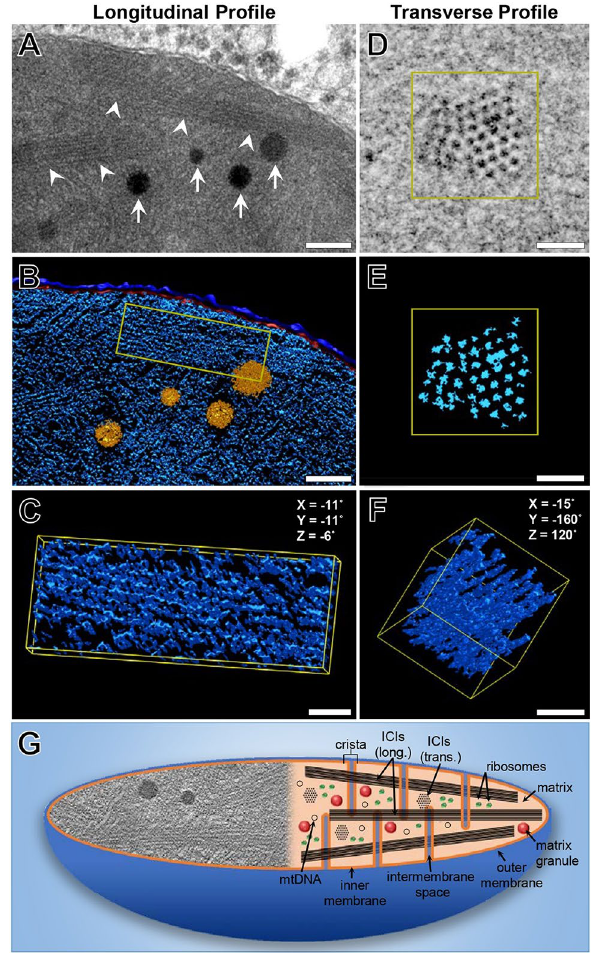
Figure 5. The 3-D structure of intramitochondrial crystalline inclusions (ICIs) and enlarged matrix granules revealed by transmission electron tomography. ( A ) High-magnification image (15,000× magnification) of longitudinal arrays of ICIs (arrowheads) and enlarged matrix granules (arrows) distributed throughout the mitochondrial matrix. ( B ) 3-D model view of the outer- (dark blue) and inner mitochondrial membranes (red), ICIs (light blue) and enlarged matrix granules (orange), corresponding to ( A ). ( C ) Higher-magnification model view of a bundle of ICIs corresponding to the yellow bounding box in ( B ). ( D ) High-magnification image (30,000× magnification) and corresponding model view ( E ) of a bundle of ICIs in transverse section. The individual rod-like filaments appear to be composed of globular subunits, measuring 8.65 ± 1.31 nm in diameter and are arranged in a rhomboid pattern with regular periodicities of 7.38 ± 1.61 nm. ( F ) Rotated model view relative to ( E ) indicating the rod-like inclusions are organised as individual filaments, and not lamellar sheets as may be perceived from 2-D TEM micrographs. ( G ) Schematic diagram revealing the internal ultrastructure of giant mitochondria. The left-hand side of the diagram reveals a 2-D image of common ultrastructural abnormalities within the matrix of giant mitochondria, such as ICIs enlarged matrix granules and disrupted cristae. The right-hand side of the diagram reveals characteristic features of giant mitochondria that may not be observed in their entirety in a single image, or a single magnification, including: mitochondrial DNA, ribosomes, matrix granules, the inner- and outer mitochondrial membranes and intervening intermembrane space, as well as ICIs in both longitudinal and transverse profile. Scale bars: ( A & B ) 200 nm; ( C – F ) = 50